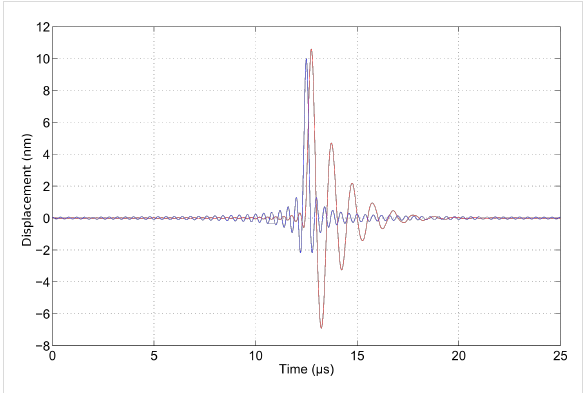
Figure 3: The response of a damped harmonic oscillator (red line, quality factor Q = 4) to a sinc driver (blue line) with an amplitude of